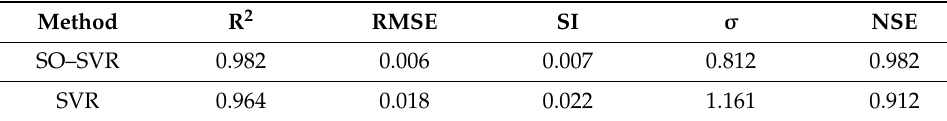
Figure 9 shows the error distribution diagrams of SO–SVR and SVR on the test stage. The results show that about 75% of the yield values estimated utilizing the SO–SVR have an error of less than 2%, while in the SVR, 64% of the yield values calculated have an error of less than